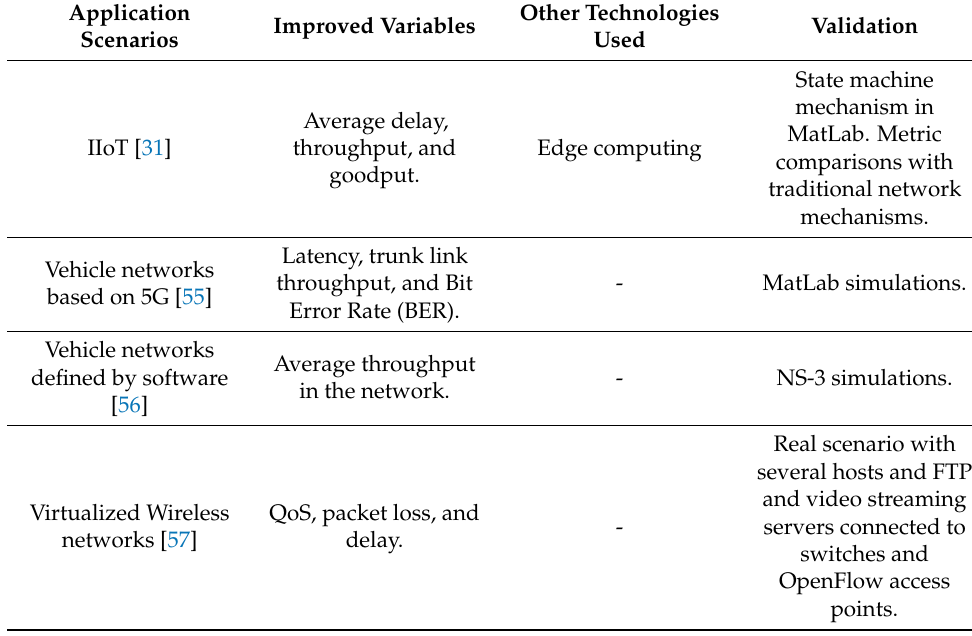
Table 1. Adaptive transmission in IIoT